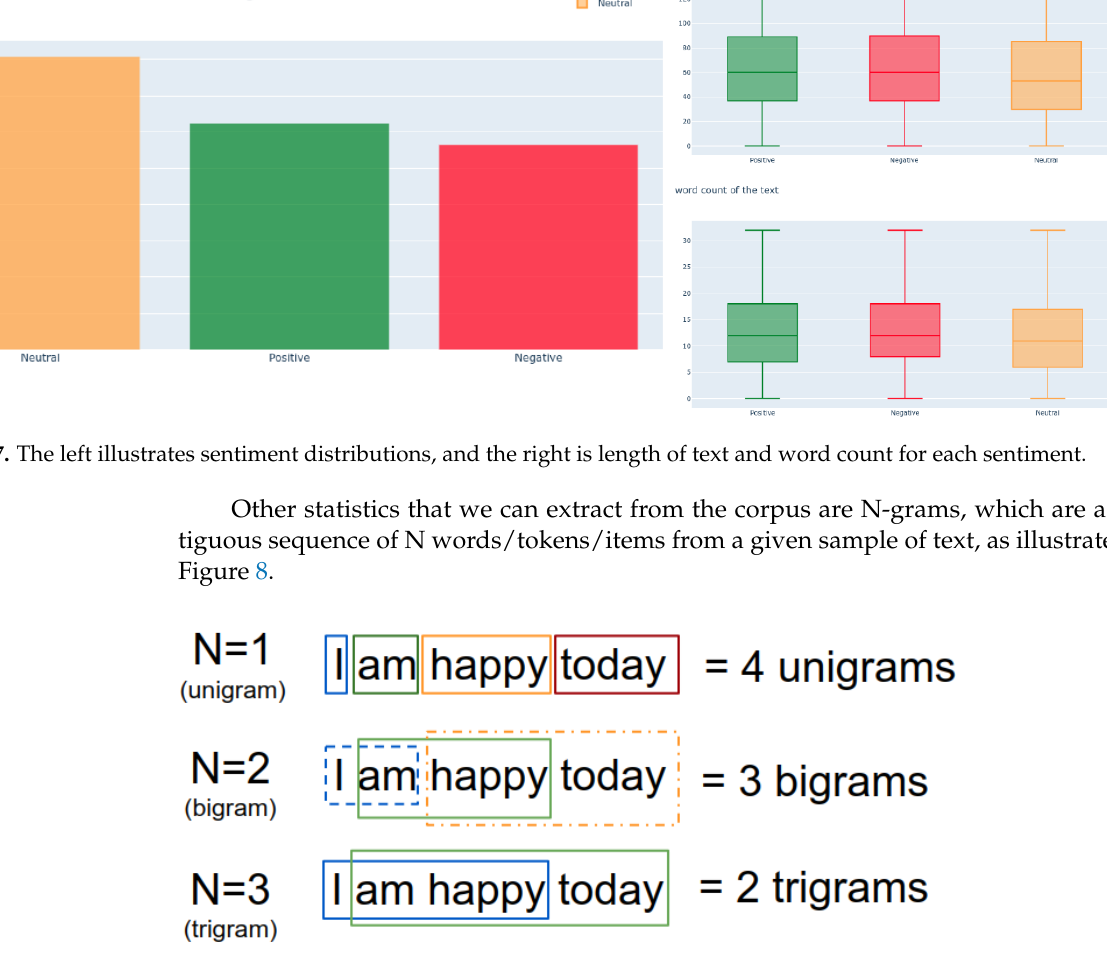
Figure 8. Examples of N -grams. Each box groups words depending on N